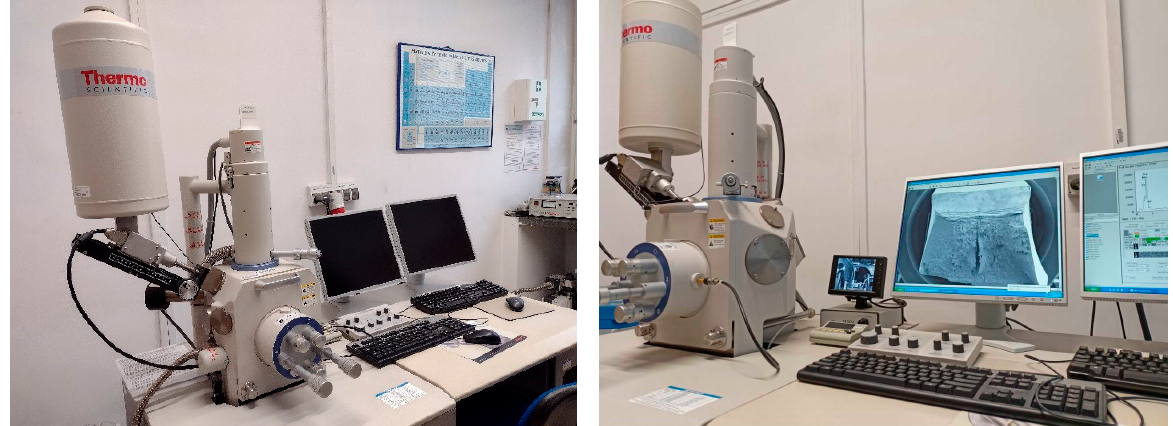
Figure 9. Scanning electron microscope (SEM) used to analyze the microstructure of considered steel.